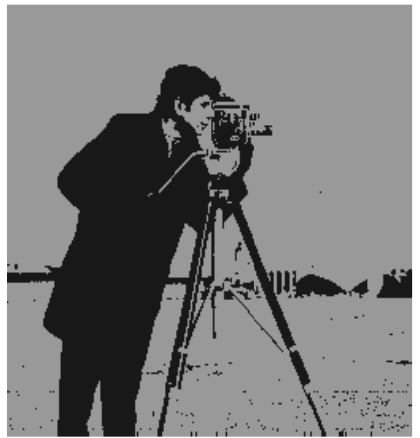
Figure 29. Cameraman using FP-Conv-CM. Figure 30. Archimedes using GMM. Figure 31. Archimedes using FCM.